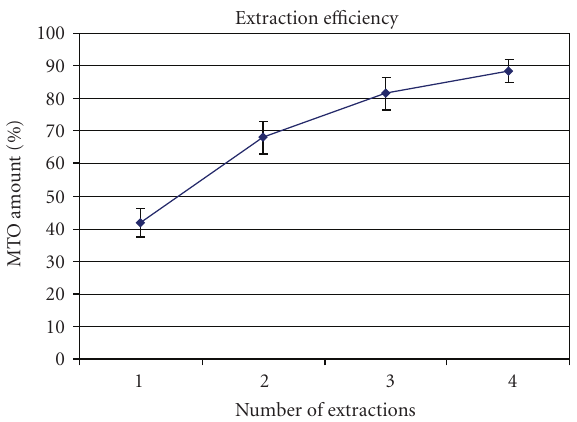
Figure 2: Extraction e ffi ciency: extraction with: 500 μ L water, 200 μ L MeOH, 50 μ L ascorbic acid (20%) in citrate bu ff er (pH 3.0), 200 μ L formic acid, 100 μ L 20% trichloroacetic acid, and 400 μ L chloroform in an ultrasonic bath. Recovery rate in dependence to multiple extractions. 4 fold extraction is nearly quantitative. Each reading point was measured in